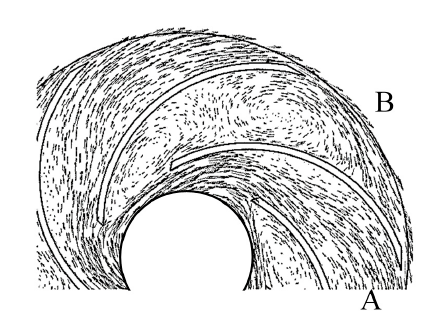
Figure 4. Relative velocity ( V ) vectors on the spanwise 50% surface by CFD, the experimental pattern can be found in Reference [32].